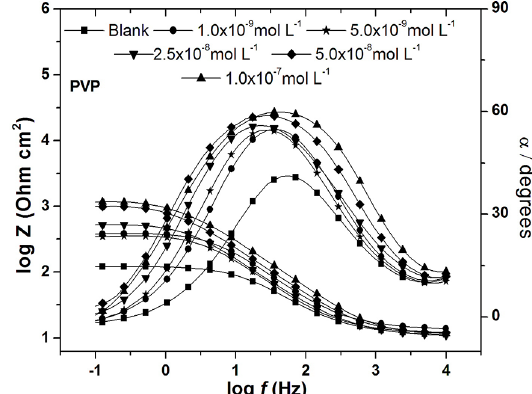
Figure 4. Nyquist plots of carbon steel obtained in HCl 0.5 mol L -1 , in the blank and in the presence of PVP 40000.